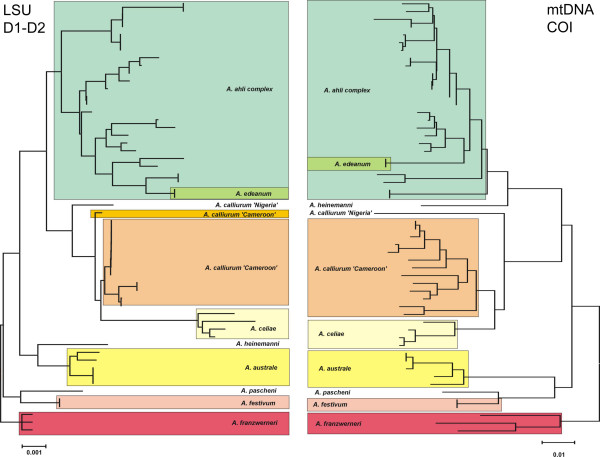
A comparison between LSU and mtDNA sequences with respect to species level resolution for the Aphyosemion calliurum species group with a complete taxon sampling. For species with larger distribution several populations were sampled. Both markers assign the samples to the same groups. See text for further details.